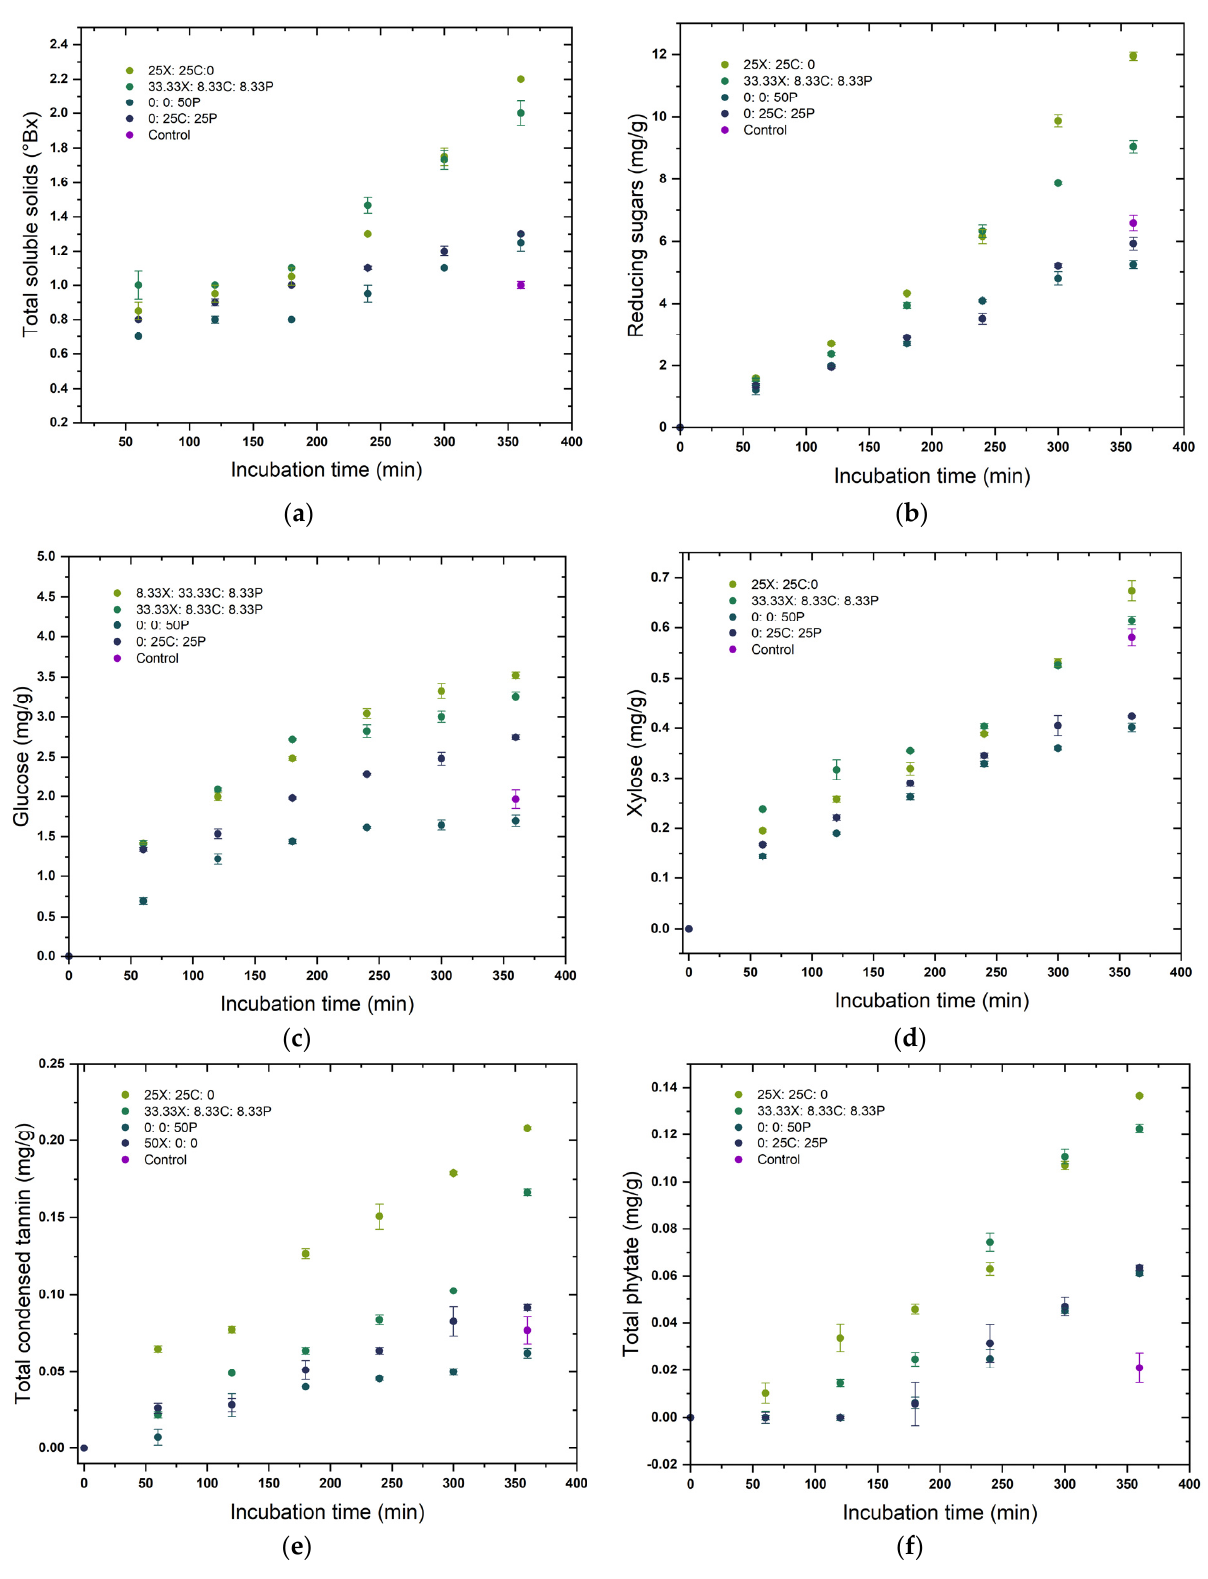
Figure 3. Time course release of pericarp components ( a ) total soluble solids, ( b ) reducing sugars, ( c ) glucose, ( d ) xylose, ( e ) total condensed tannins, and ( f ) total phytate upon treatment with different enzyme cocktail formulations. X: xylanase; C: cellulase, and P: pectinase.